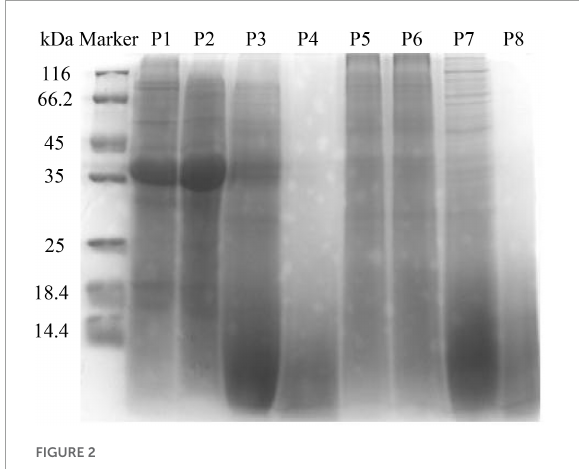
FIGURE2 SDS-polyacrylamide gel electrophoresis (SDS-PAGE) patterns of samples in different simulated digestion stages.